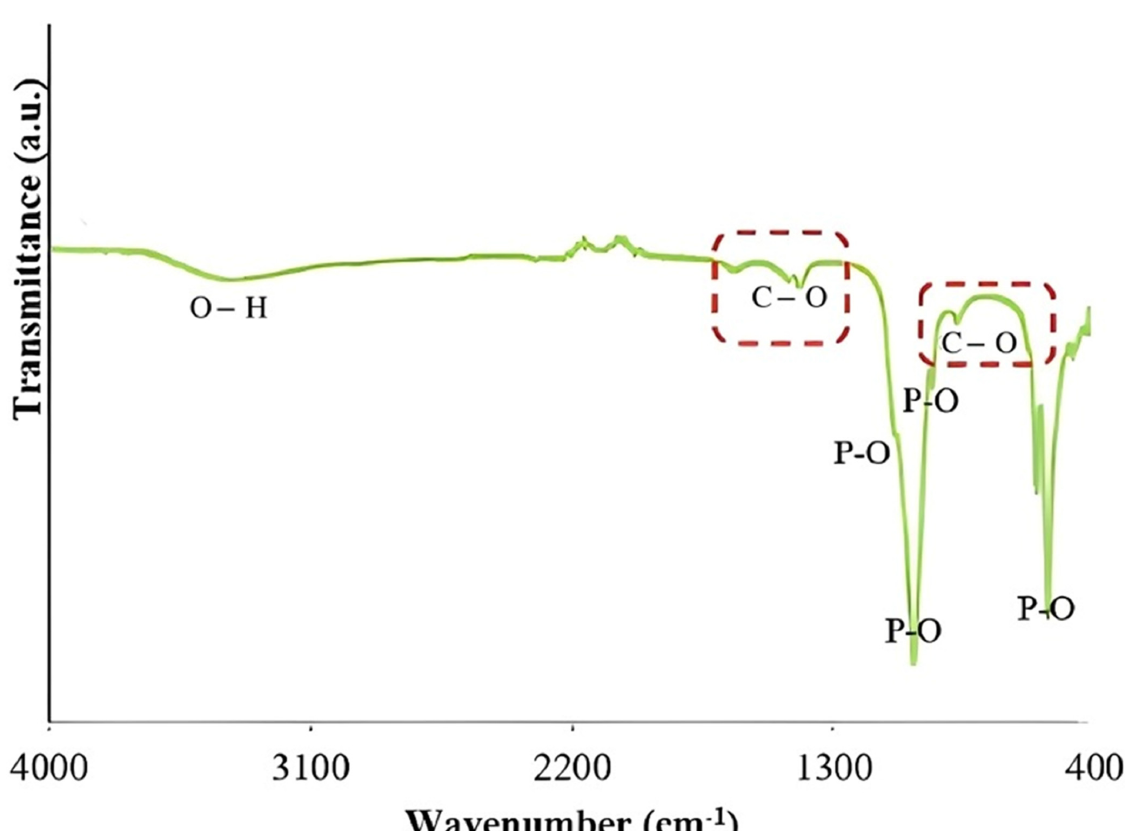
Figure 2. FTIR spectra of cockle shell powder.